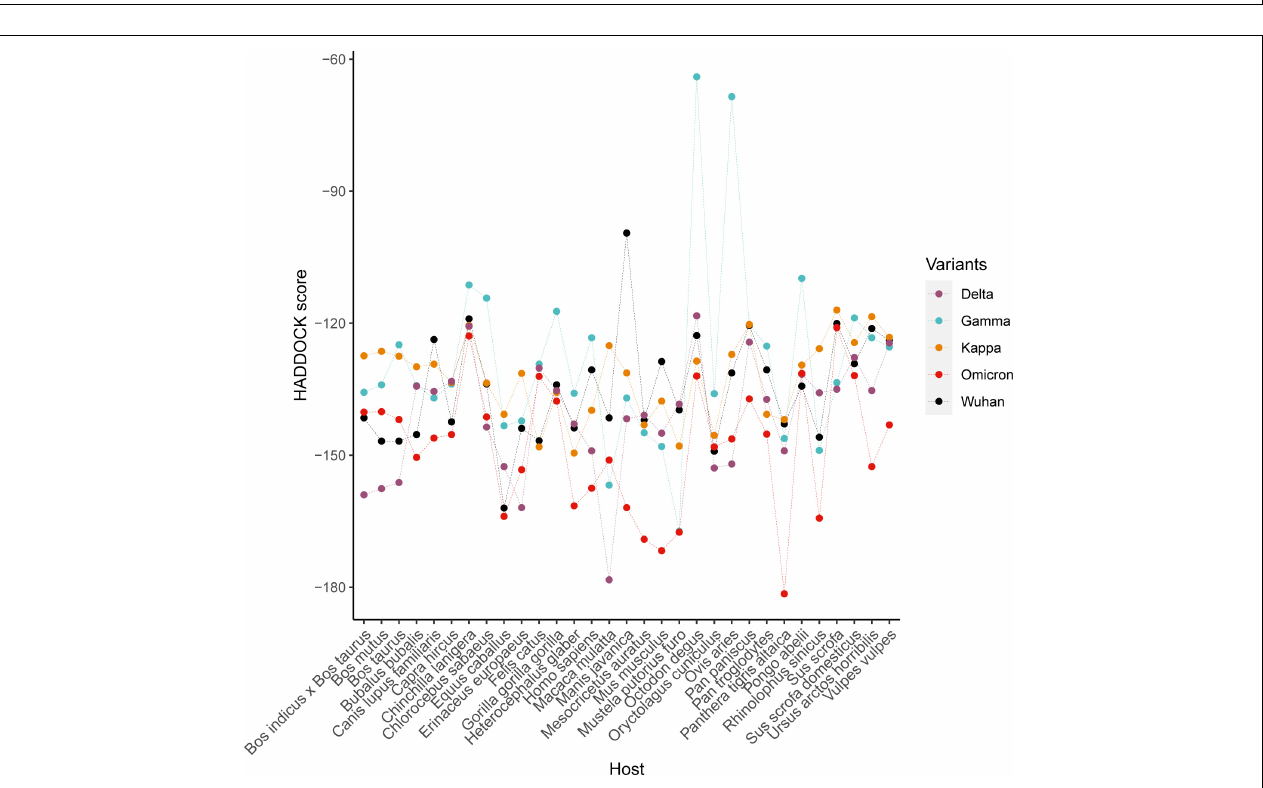
FIGURE 4 | Binding sites of ACE2 protein and spike protein. (A,B) The binding sites of cat ACE2 and the SARS-CoV-2 RBD. (C) The binding sites of ferret ACE2 and the SARS-CoV-2 RBD. The red line represents the hydrogen bond.